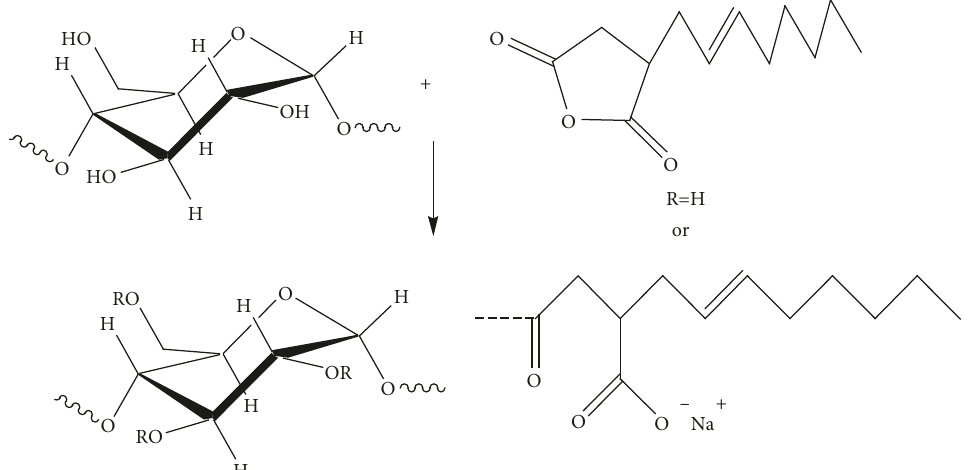
Starch-based Scheme 3: Preparation of starch-based polyurethane [70].